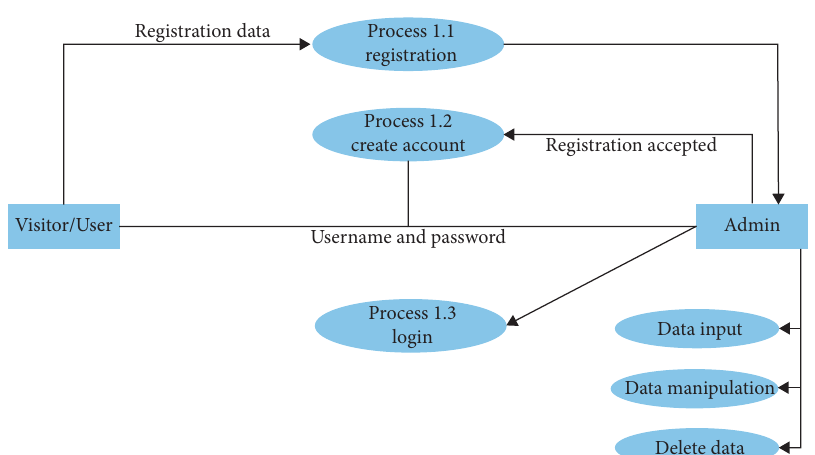
Figure 4: Data flow diagram user management (DFD level 1).